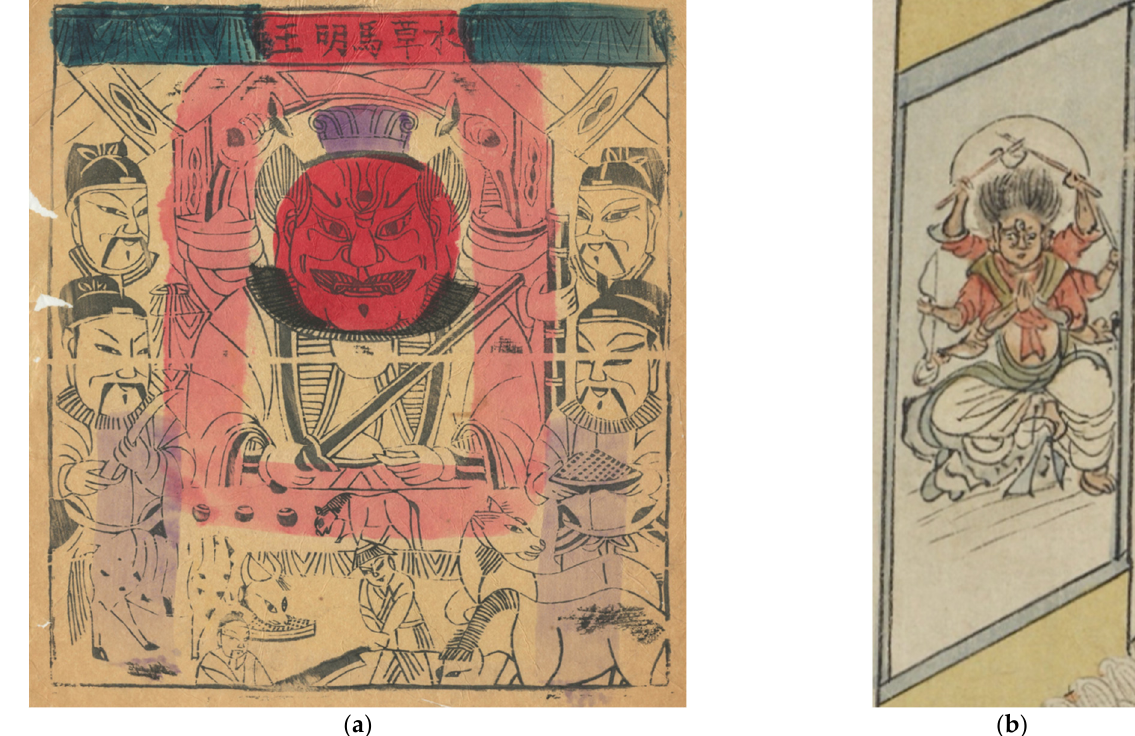
Figure 11. The images of” Shui-Cao-Ma-Ming-Wang 水草马明王 ”: ( a ) “Shui-Cao-Ma-Ming-Wang 水草马明王 ”. Wood Engraving New Year pictures. Held by Columbia University Libraries. Photo